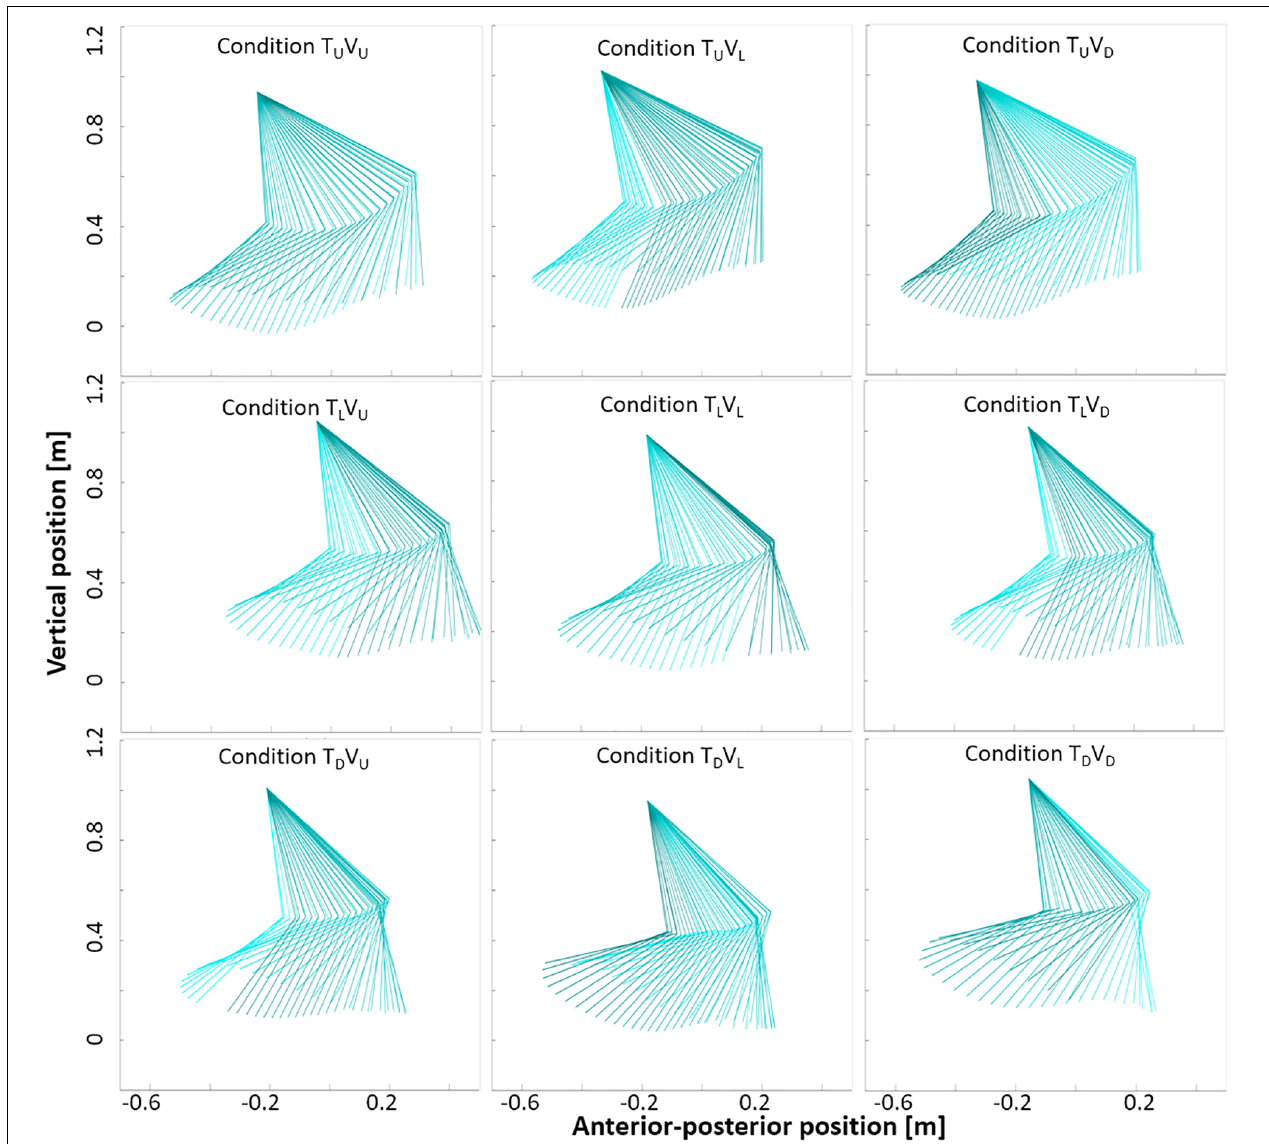
FIGURE 9 | Thigh and shank movement in the nine experimental conditions. Sagittal plots of right lower-limb angles in one representative participant during a single gait cycle taken from 0 to 20 s post-transition (incongruent conditions) and from stable walking (congruent conditions: 48–60 s post-transition). Data from the pelvis, knee and ankle defined the two segments of thigh and shank. Darker color indicates backward movement, and lighter color indicates forward movement. Visual cues appear to influence lower-limb movement during incongruent conditions in a manner consistent with the (visually) corresponding congruent condition. In particular, range of movement appears consistently narrower in conditions with a downward visual transition (see Table 1